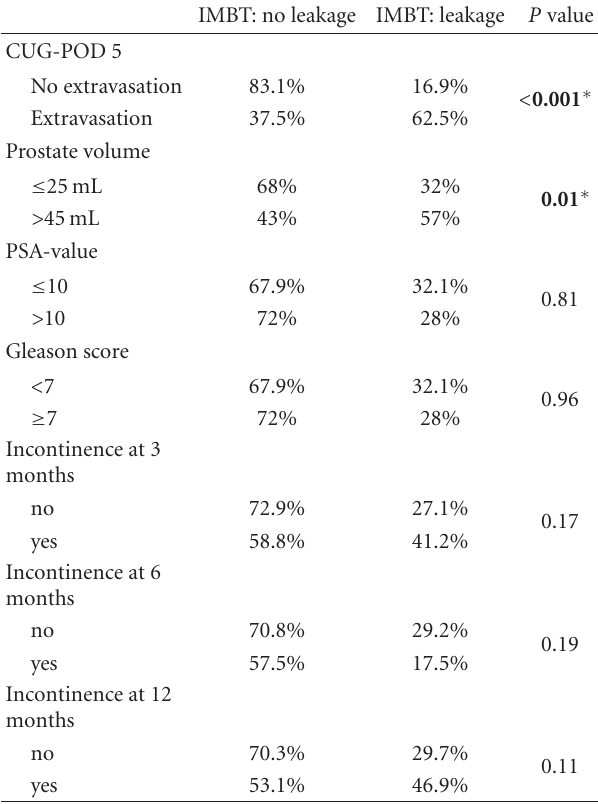
Table 1: Relation between patient characteristics and intraoperative methylene blue